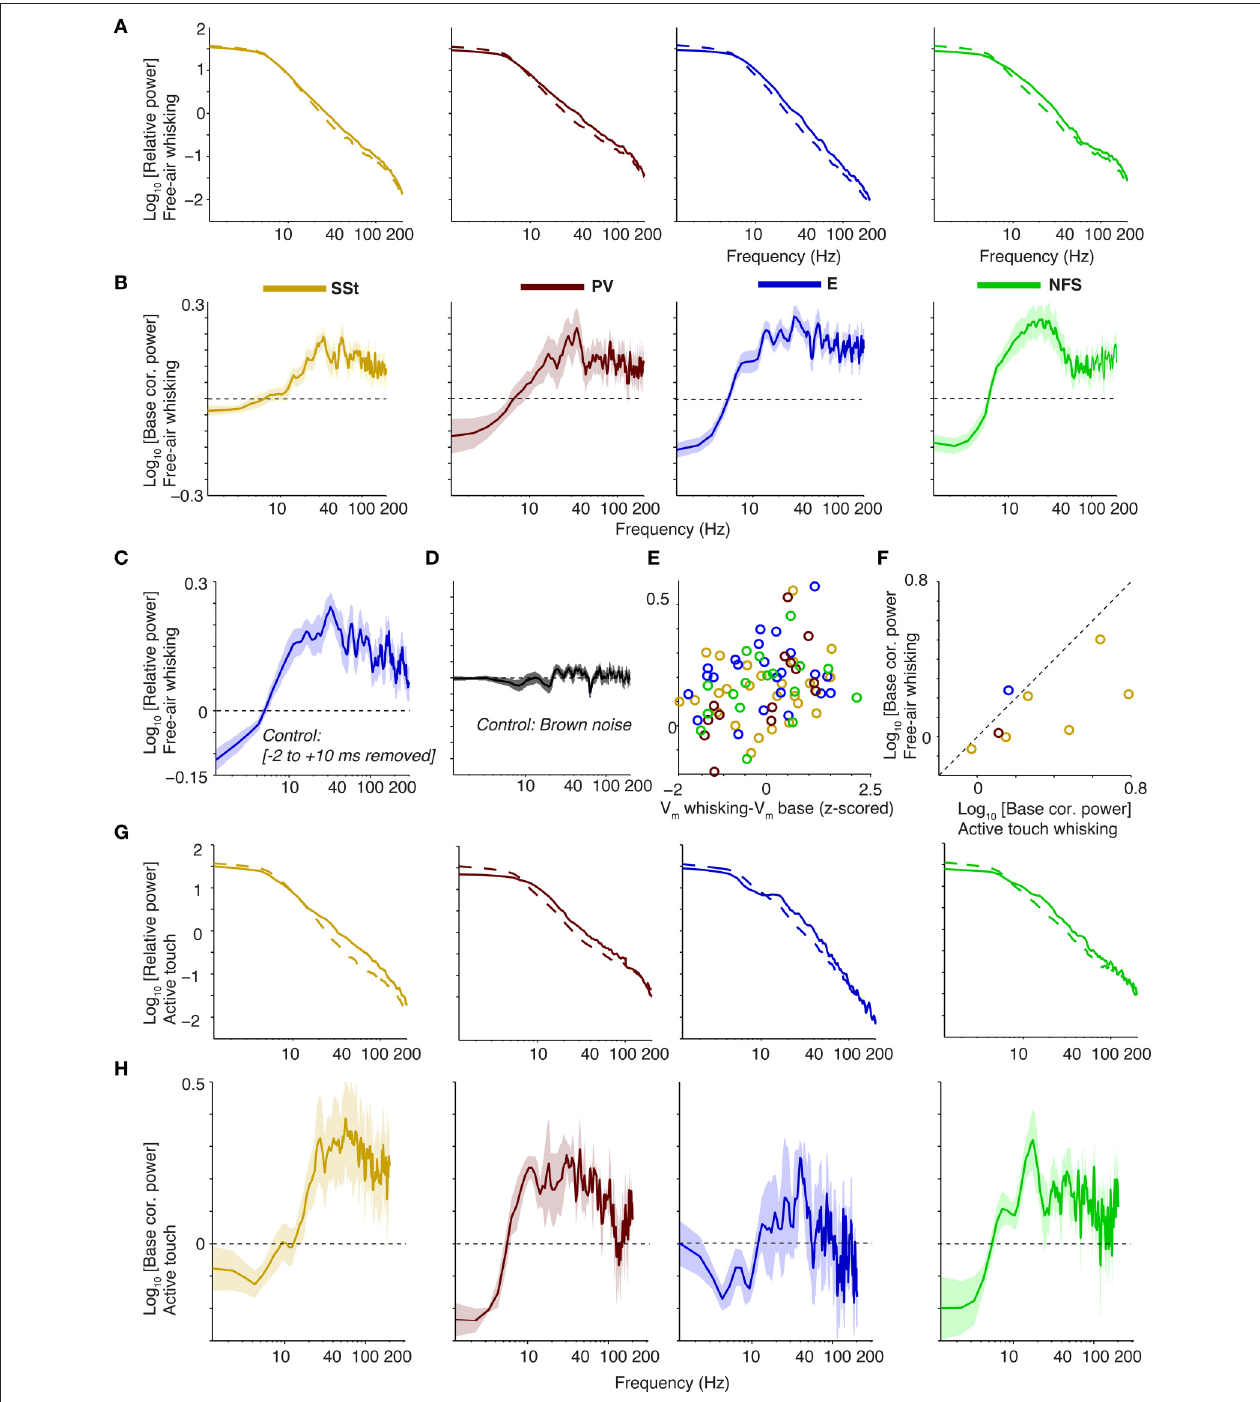
FIGURE 11 | Gamma power increases in the V m of whole-cell recorded cell types during free-air whisking and active touch in S1BF of the mouse. (A) From left-to-right: relative power spectra (relative to sum of power across frequencies during baseline) for free-air whisking (solid) and baseline (dashed) for SSt interneurons, FS PV interneurons, excitatory, and NFS GABAergic interneurons. Shadings indicate SEMs. (B) As (A) , but now shown power change during free-air whisking relative to baseline ( log 10 transformed) (C) Same as (A) , third column, but now removing − 2 to 10ms around every spike. (D) Power change during free-air whisking relative to baseline ( log 10 ) for all cells together where original traces have been replaced by random Brownian 1 / f 2 noise. (E) Power change during free-air whisking relative to baseline ( log 10 ) as a function of the Z-scored difference in mean membrane potential difference between free-air whisking and baseline. (F) Power change during active touch whisking relative to baseline ( log 10 ) vs. power change during free-air whisking relative to baseline ( log 10 ). (G,H) As (A,B) , but now for active touch. Panel (H) shown on same scale as (B) .